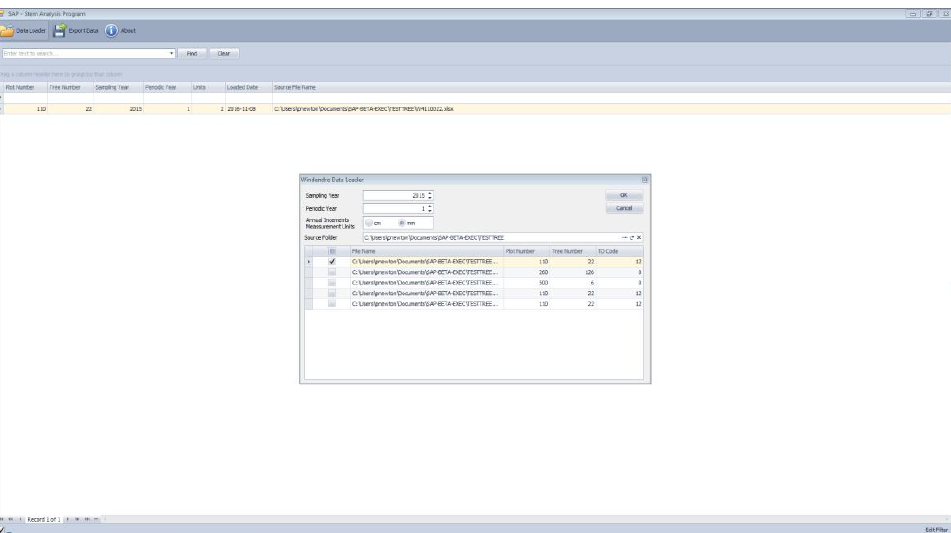
Figure 1. Screenshot of the “Data Loader” tool bar for the example tree.